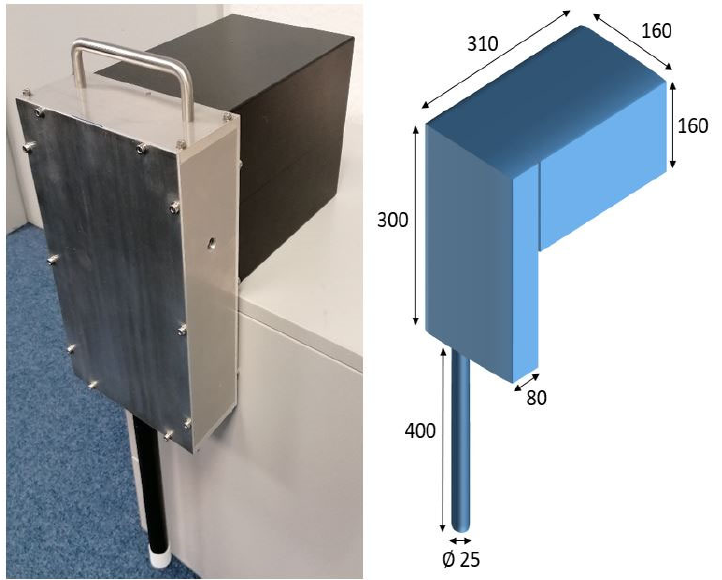
Figure 1. Image of the completed prototype in a custom aluminum housing. The bottom of the probe has a protective cap. All dimensions are given in mm.